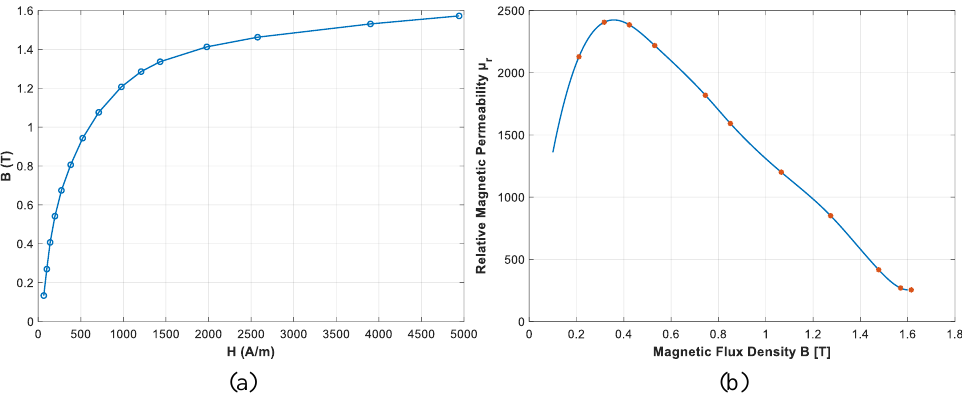
Figure 9. The measured BH loop for a complete stator at different excitation levels (0.1 T–1.6 T) at 400 Hz.